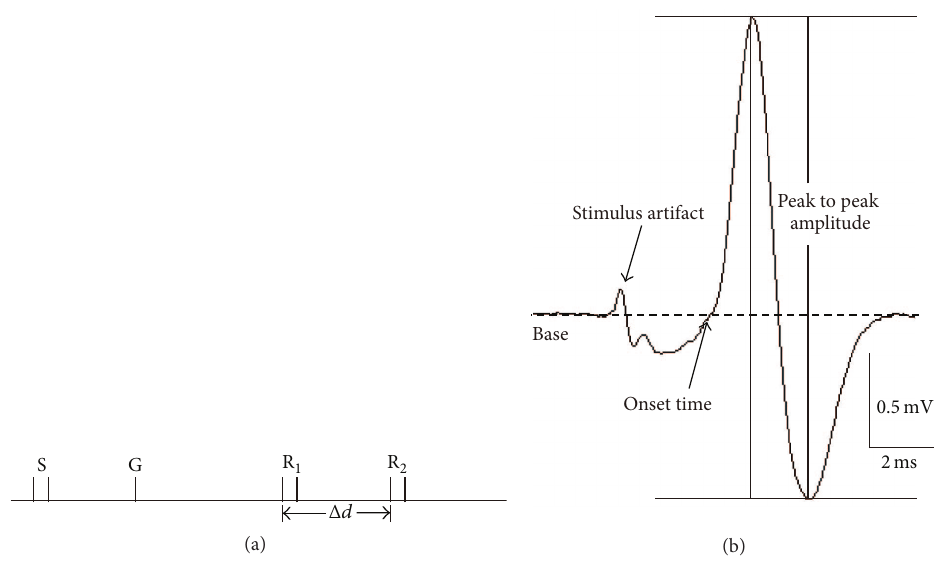
Figure 1: CNAP determination. (a) Set of the 7 Ag/AgCl electrodes, including S (1 pair of stimulating electrodes), G (1 grounding electrode), and R1 and R2 (2 pairs of recording electrodes). Δ𝑑 is the space between the electrodes of R1 and R2, which were fixed during the whole procedure. (b) A normal sample trace of CNAP without drug exposure. The time points of the onset time, peak to peak amplitude are shown.